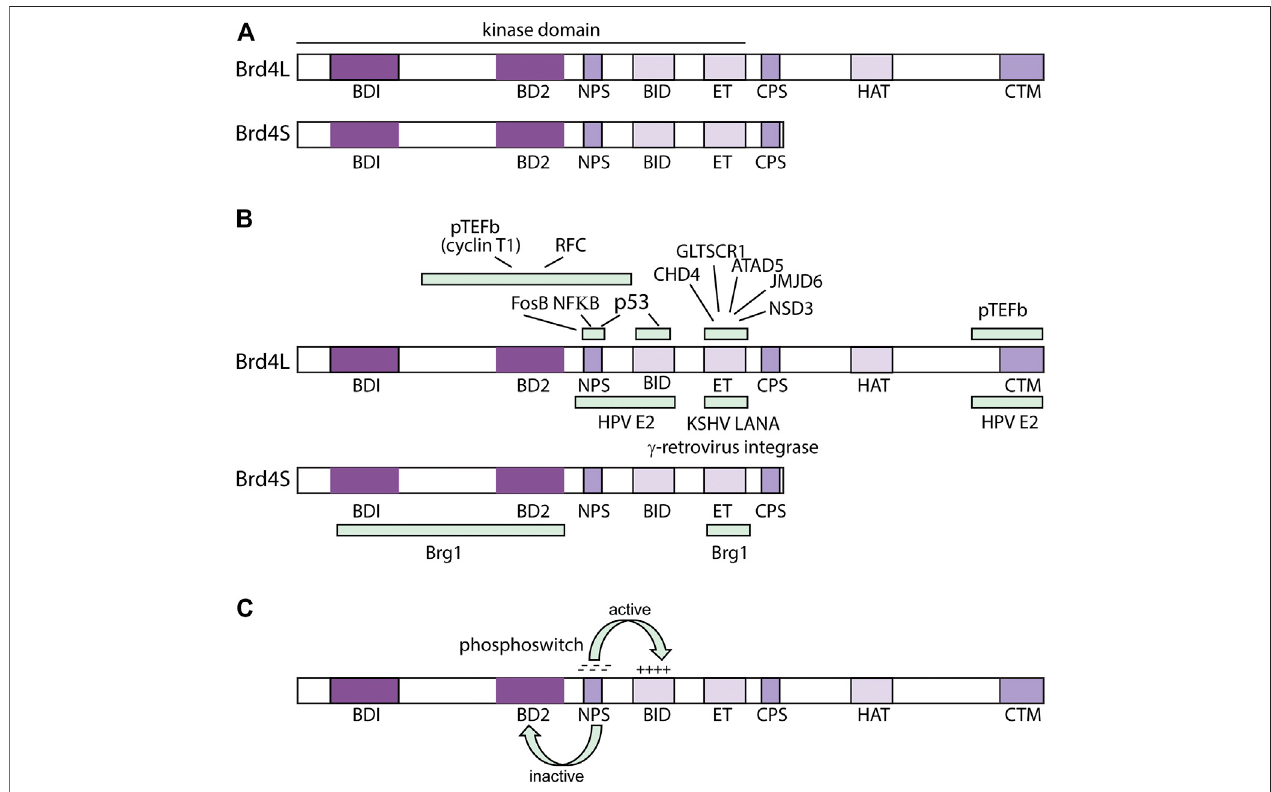
FIGURE 4 | Structure and Function of the Brd4 protein. (A) Domains of the Brd4 protein. BRD4L and Brd4S domains are shown: BD1 (bromodomain I: residues 58 – 169); BD2 (bromodomain 2: residues 349 – 461); NPS (N-terminal cluster of phosphorylation sites: residues 484 – 503); BID (basic residue enriched interaction domain: residues 524 – 579); ET (extra-terminal domain: residues 600 – 678); CPS (C-terminal cluster of phosphorylation sites: residues 699 – 717), HAT (HAT catalytic domain: residues 1122 – 1161); CTM (C-terminal motif: residues 1,325 – 1,362) from (Devaiah B. N. et al., 2016). (B) Regions of Interaction of Brd4 with viral and cellularfactors.From(Bisgroveetal.,2007;Youetal.,2004;Youetal.,2006;WuandChiang,2007;Rahmanetal.,2011;Sharmaetal.,2013;Wuetal.,2013;Wuetal., 2016). (C) Brd4 Phosphoswitch. Phosphorylation ofthe NPS region by CK2 activates Brd4 by unmasking BD2. This also regulates interaction with the HPV E2 proteins (see text for details). From (Wu et al., 2013; Chiang, 2016; Wu et al.,